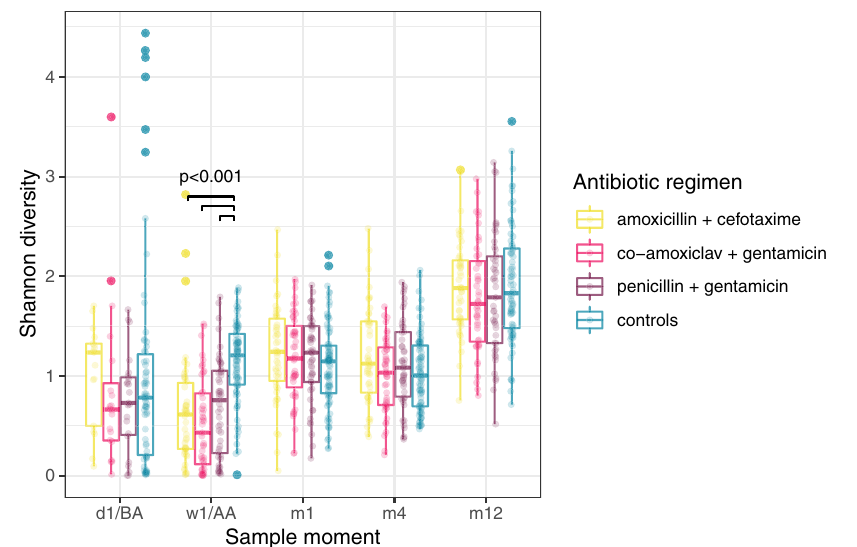
Fig. 1 α -diversity. Differences in Shannon diversity of the faecal microbiota between infants treated with the three studied antibiotic regimens and controls plotted per time point. Group differences were calculated using one-sided Wilcoxon tests. Boxplots with medians are shown; the lower and upper hinges correspond to the fi rst and third quartiles (the 25 th and 75 th percentiles); the upper and lower whiskers extend from the hinge to the largest and smallest value no further than 1.5*IQR from the hinge; outliers are plotted individually by opaque circles; translucent circles visualize all data points (yellow = amoxicillin + cefotaxime [ n = 17, n = 46, n = 46, n = 45 and n = 44 for the consecutive time points], pink = co-amoxiclav + gentamicin [ n = 20, n = 45, n = 47, n = 46 and n = 44], purple = penicillin + gentamicin [ n = 23, n = 48, n = 47, n = 46 and n = 45], teal = controls [ n = 66, n = 80, n = 80, n = 78 and n = 74]. D = day, w = week, BA = before antibiotics, AA = after antibiotics, m = month. We observed a signi fi cant difference in Shannon diversity between each antibiotic regimen and the controls directly after antibiotic treatment ( p = 4.915e-09 for amoxicillin + cefotaxime vs. controls, p = 4.056e-10 for co- amoxiclav + gentamicin vs. controls and p = 9.128e-07 for penicillin + gentamicin vs. controls). Source data are provided as a Source Data fi